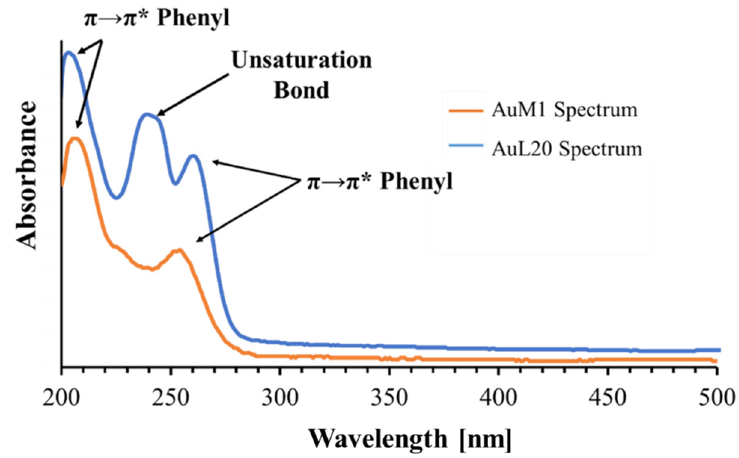
Figure 3. Spectra of AuM1 and AuL20.